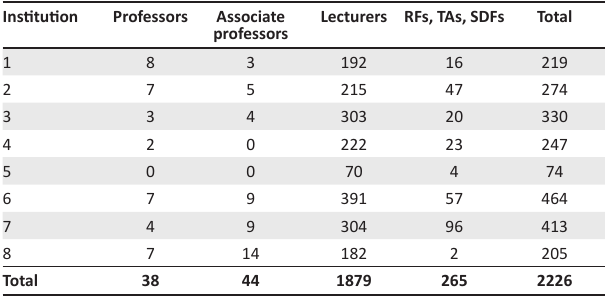
TABLE 2: Academic staff establishments at the universities.